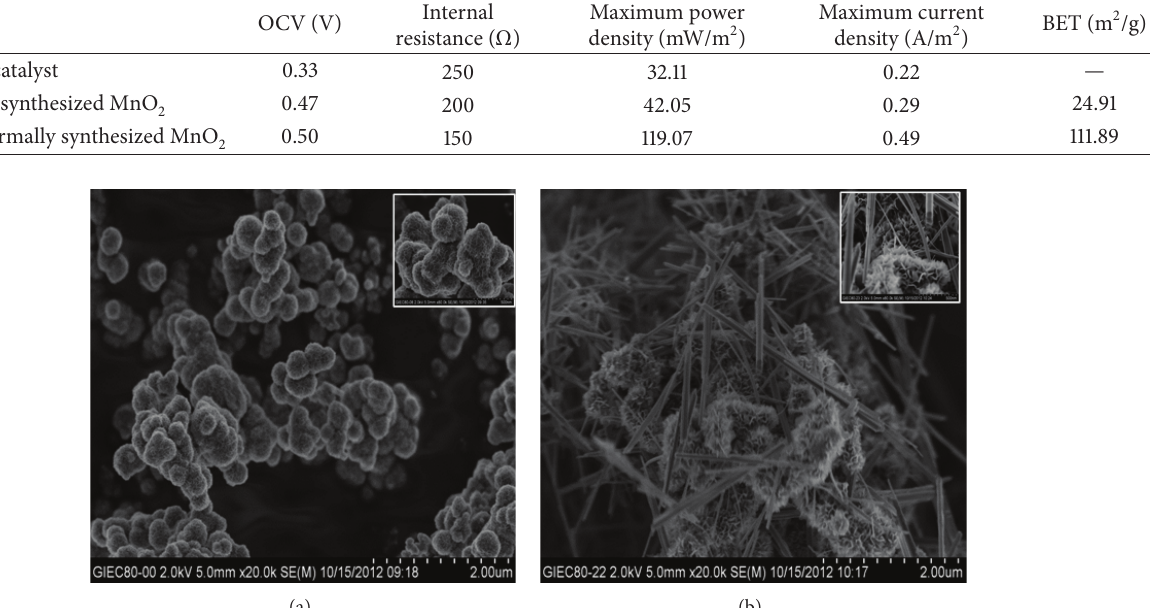
Figure 1: SEM images of MnO 2 prepared by different methods: (a) natural process; (b) hydrothermal process. The inset images are the higher magnifications.